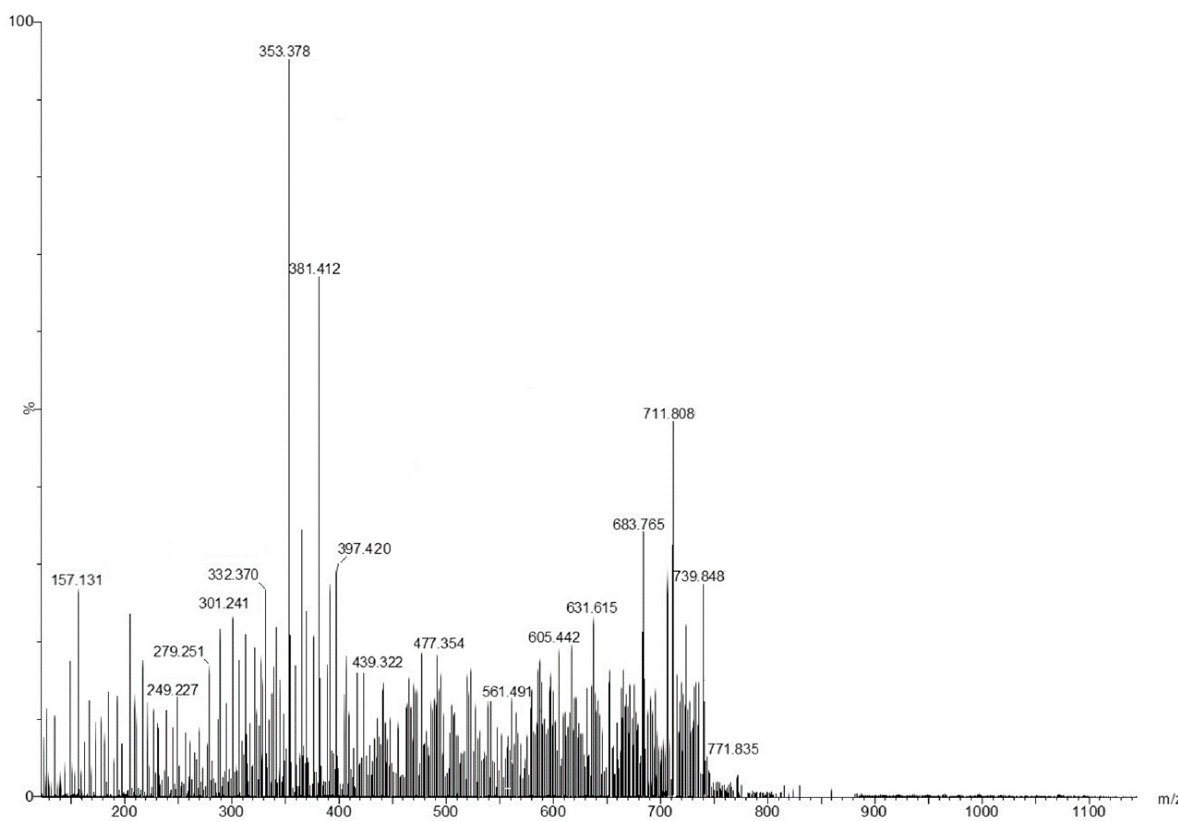
Figure 1. The mass spectrum of Romanian Viscum album hosted on Quercus robur L. (collected on summer solstice). Table 1. Components identified through electrospray ionization–quadrupole time-of-flight mass spectrometry (ESI-QTOF-MS) analysis.